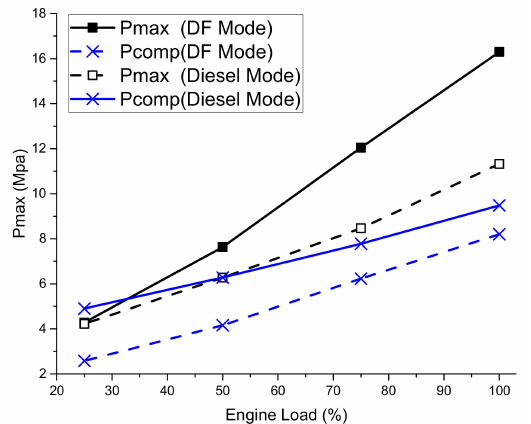
Figure 6. Comparison of dual fuel mode and diesel mode.